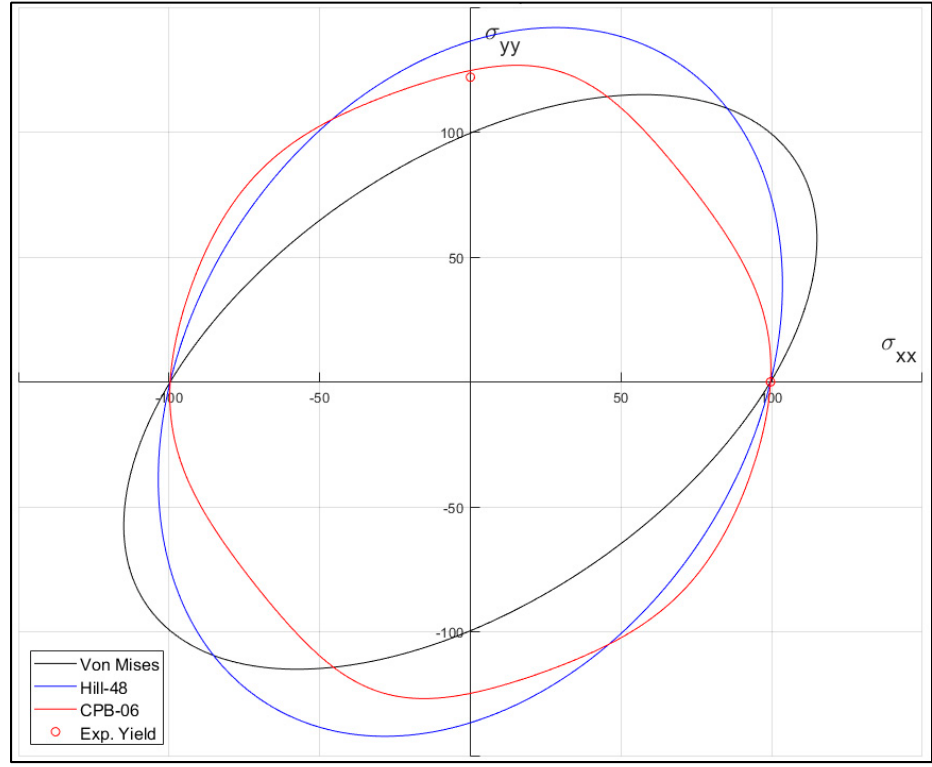
Figure 5. Plane stress yield envelope in the σ xx (cid:12) σ yy plane at the yield strength for the von Mises, Hill-48 and CPB-06 criteria (the red circles denote the yield strengths for each sample direction).